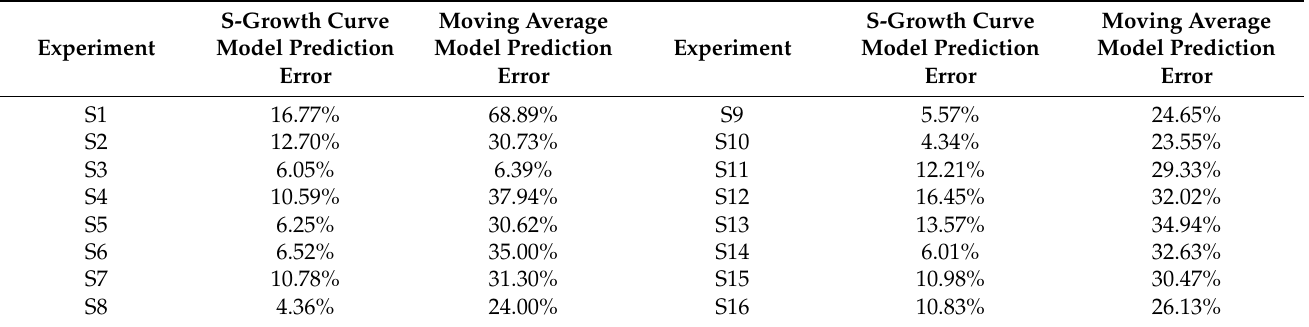
Table 4. Landslide volume error (MAPE) predicted by S-growth curve model and moving average